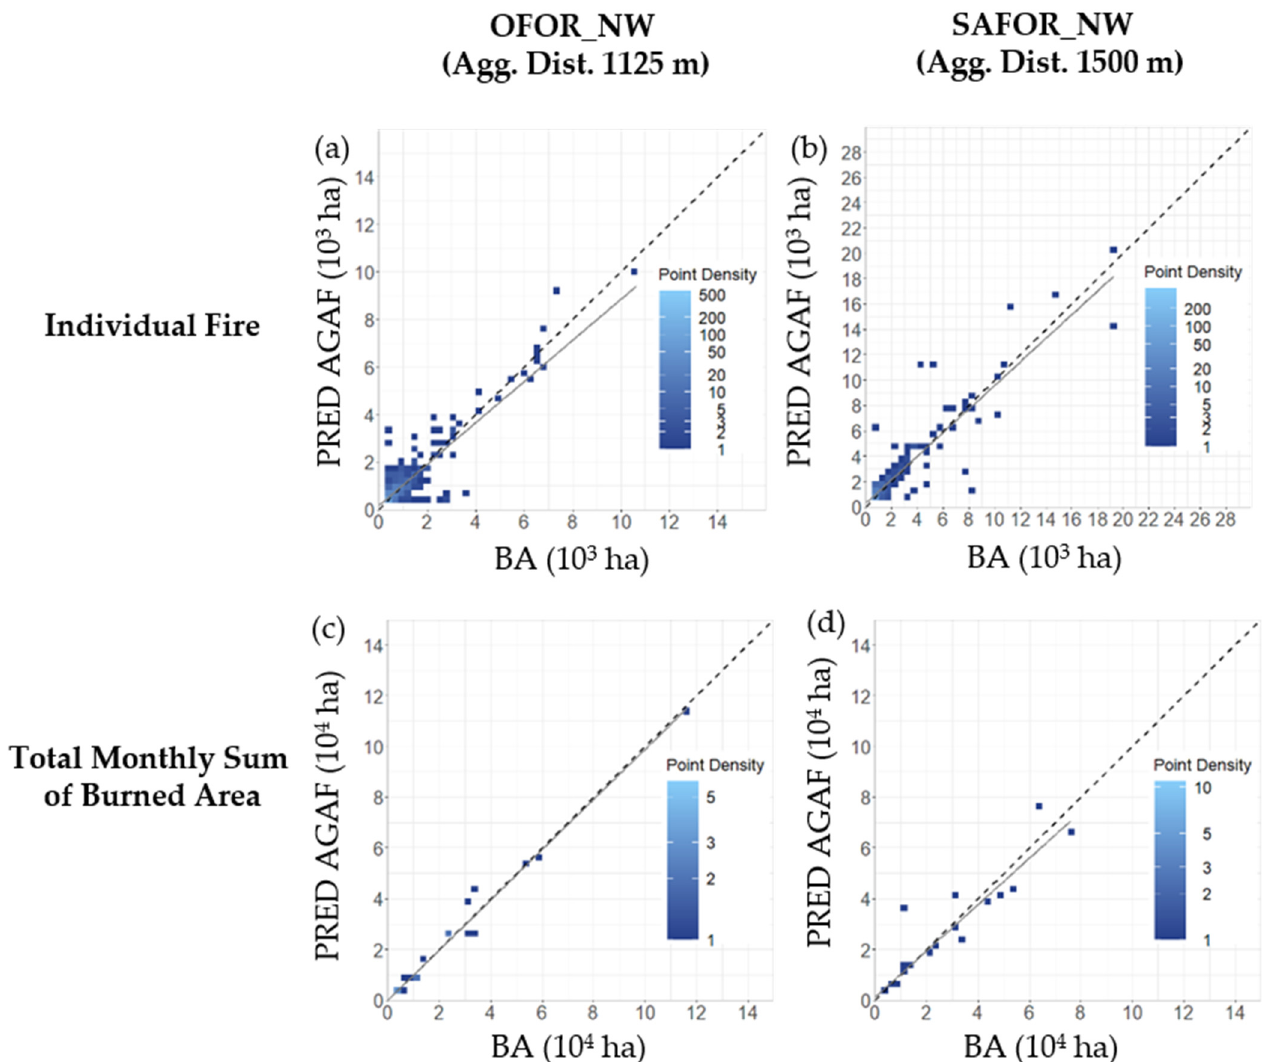
Figure 2. Predicted burned area from aggregated active fires (AGAF) against MODIS C6 MCD64A1 burned area (BA) for oak forests of the NW region ( a , c ) and semiarid forests of the NW region ( b , d ), at individual fire perimeter level ( a , b ) and total monthly sum of burned area level ( c , d ). OFOR: oak forests; SAFOR: semiarid forests (Figure 1); NW: northwest; Agg. Dist: aggregation distance; PRED AGAF: predicted burned area (using Equation (1)) from aggregated MODIS and VIIRS active fires at the specified aggregation distance; BA: MODIS C6 MCD64A1 burned area. The dotted black line shows the 1:1 line and the solid gray line shows the observed and predicted regression line. Point density values showing the number of observations by square plot division (in grey) are represented in a blue gradient.